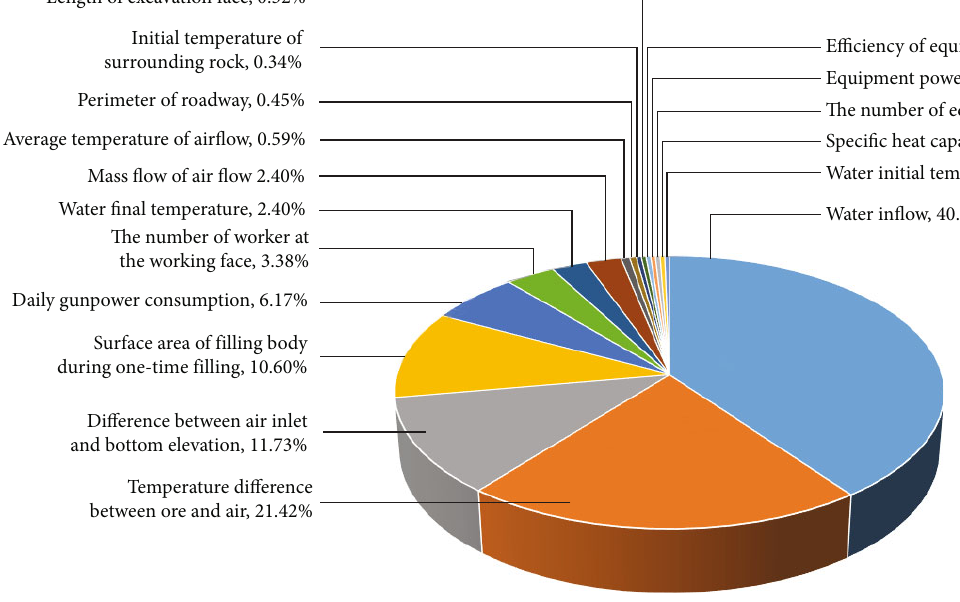
Figure 3: The pie chart of thermal environment indicators weight.